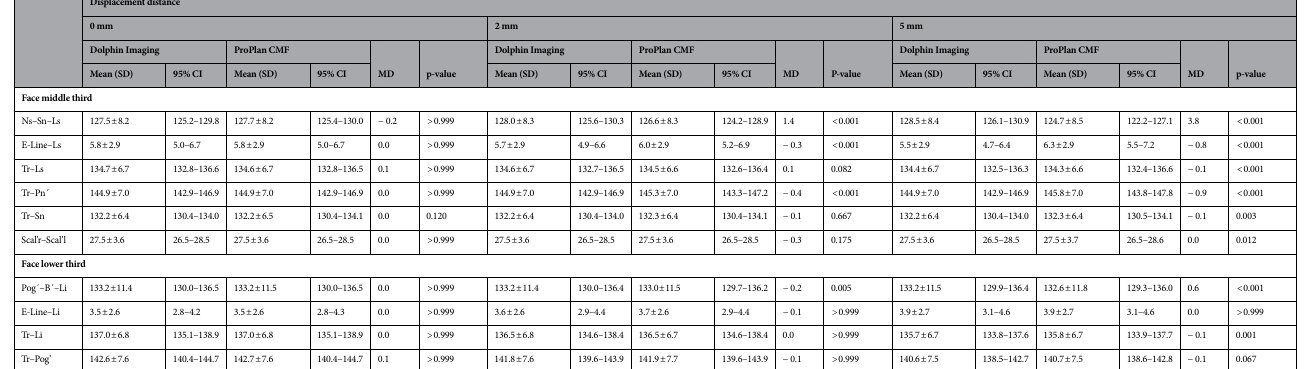
Bi-maxillary procedure (maxillary advancement and setback). The soft tissue behaved simi- larly to the simulation for maxillary advancement, but in some cases, the effects were more pronounced. Thus, the soft tissue prognosis after bi-maxillary surgery also diverged between the two programs for Ns-Sn- constant in Dolphin but increased in ProPlan (Dolphin, 0 mm: 27.5 ± 3.6 mm, + 3/ − 4 mm: 27.4 ± 3.5 mm and + 5/ − 4 mm: 27.5 ± 3.6 mm vs. ProPlan: 0 mm 27.5 ± 3.6 mm, + 3/ − 4 mm: 27.8 ± 3.6 mm and + 5/ − 4 mm: 28.1 ± 3.6 mm) . Otherwise, the simulation results of the two programs for the middle third of the face were simi- lar, but Tr-Pn and Tr-Sn increased more in ProPlan.